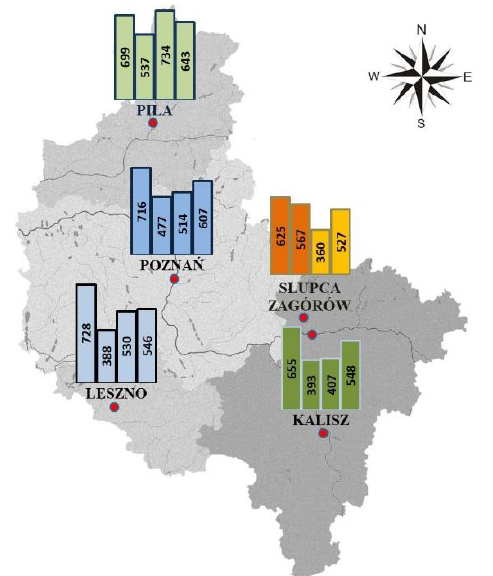
Figure 4. Annual precipitation in the analyzed years 2010 – 2013, according to specific districts of DDWA.